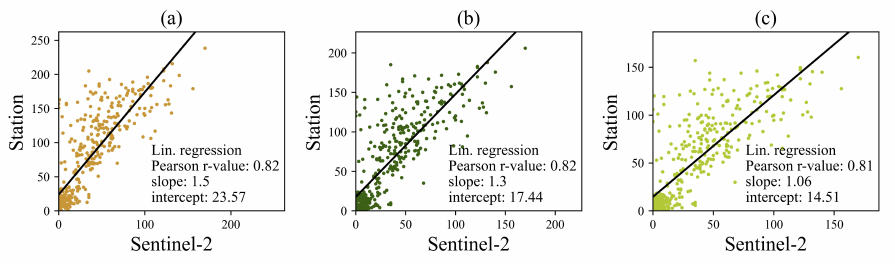
Figure 16. Comparison of Sentinel-2 truck counts with figures of different truck classes at the traffic count stations: ( a ) “Lkw” includes trucks, buses, cars with trailer. ( b ) “Lzg” is an articulated truck. ( c ) “Sat” always pulls a